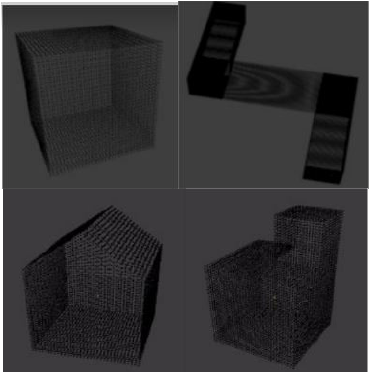
Figure 1. Sample Objects from SimLiDAR - having cube shaped, Complex Shaped, Gabled roof, Buildings with